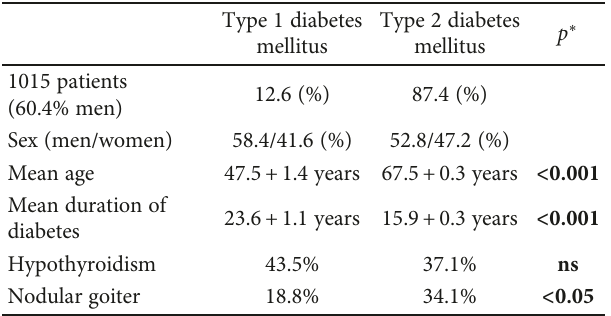
Table 1: Characteristics of patients with T1DM and